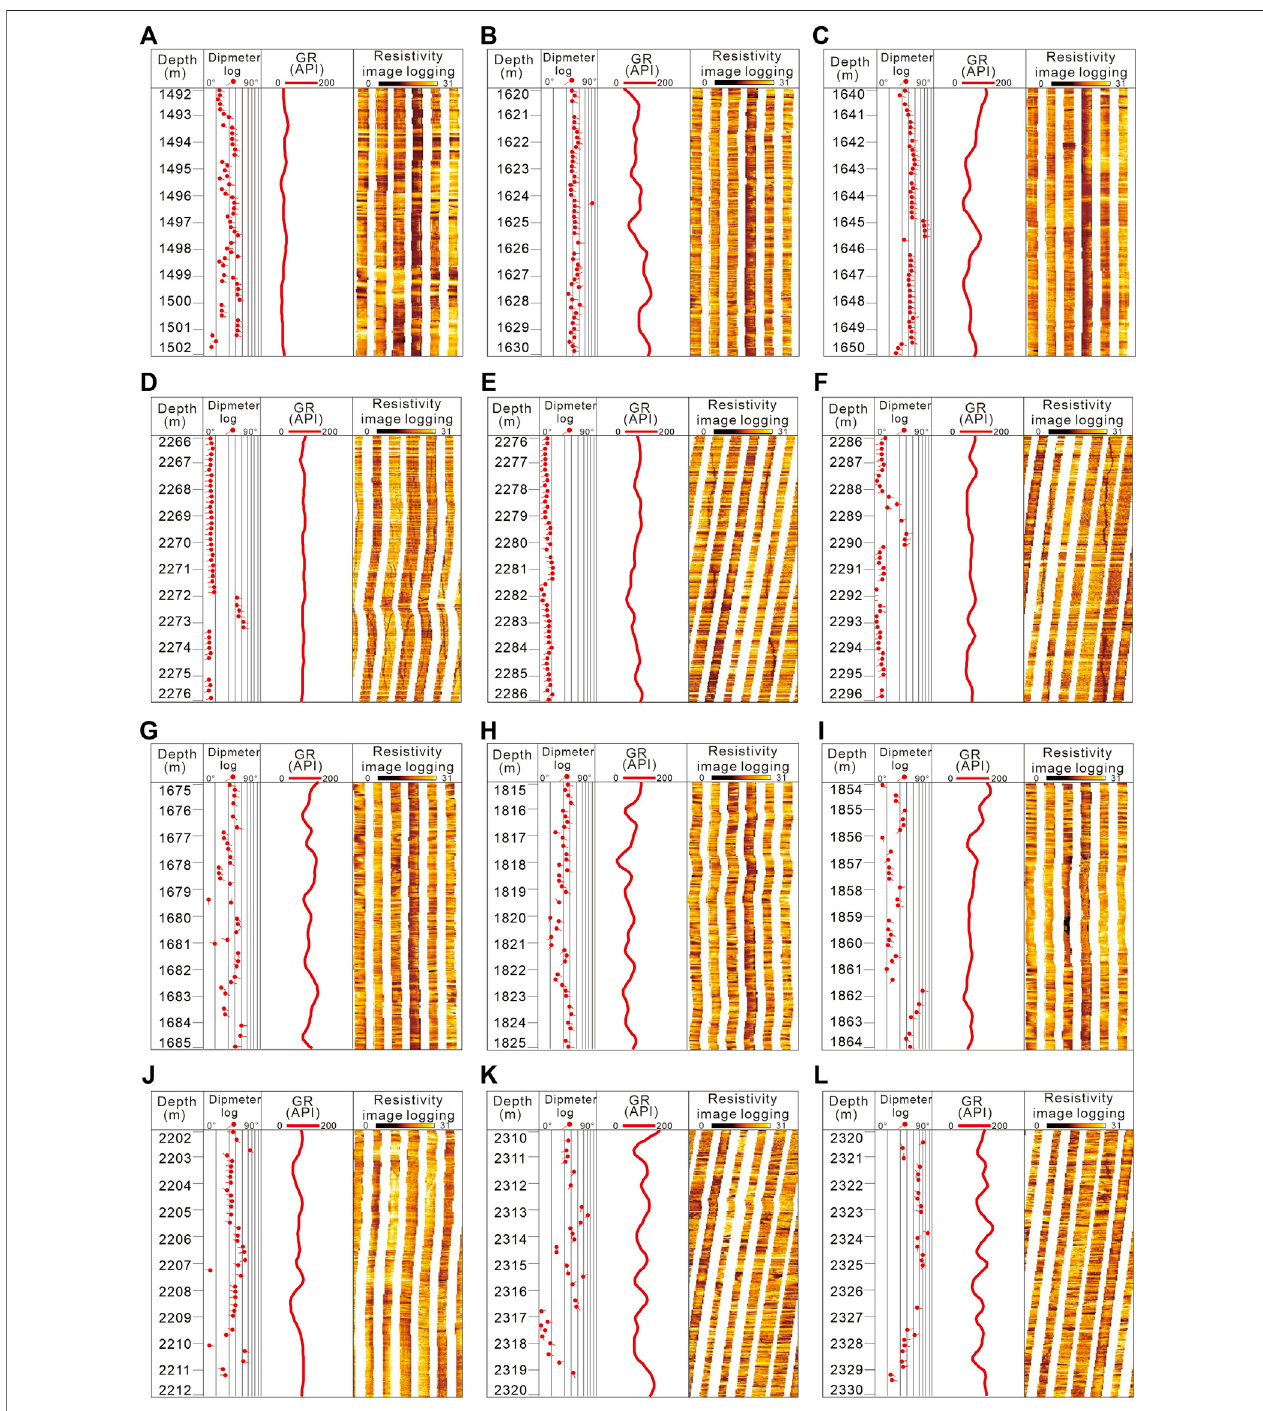
FIGURE 7 | Resistivity imaging logging map of different heterogeneous intervals. (A – F) : Parallel bedding; (G – L) : Oblique bedding.